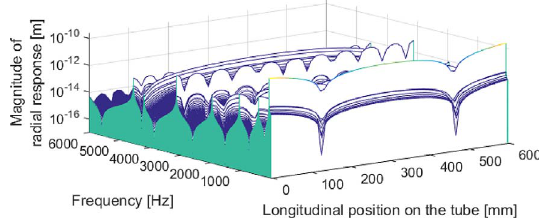
Figure 17. De fl ection in an asymmetric tube, excited by unitary internal pressure.